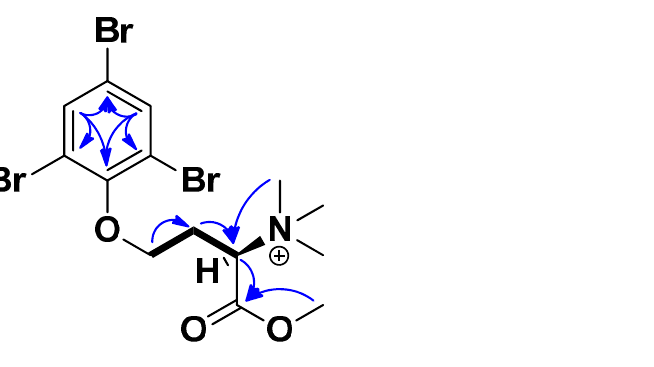
Figure 3. Key COSY (bold) and HMBC (blue arrows) correlations of purpuroine K ( 1 ). Purpuroine L ( 2 ) was isolated as a light brown wax. HRESIMS analyses supported an elemental composition of C 14 H 19 Br 2 ClNO 3 ( m / z 442.9414 [M + H] + , calculated 442.9499), requiring five degrees of unsaturation. Purpuroine M ( 3 ) was isolated as a light brown wax. HRESIMS analyses supported an elemental composition of C 14 H 19 BrCl 2 NO 3 ( m / z 398.9953 [M + H] + , calculated 399.0004), requiring five degrees of unsaturation. The 1 H and 13 C